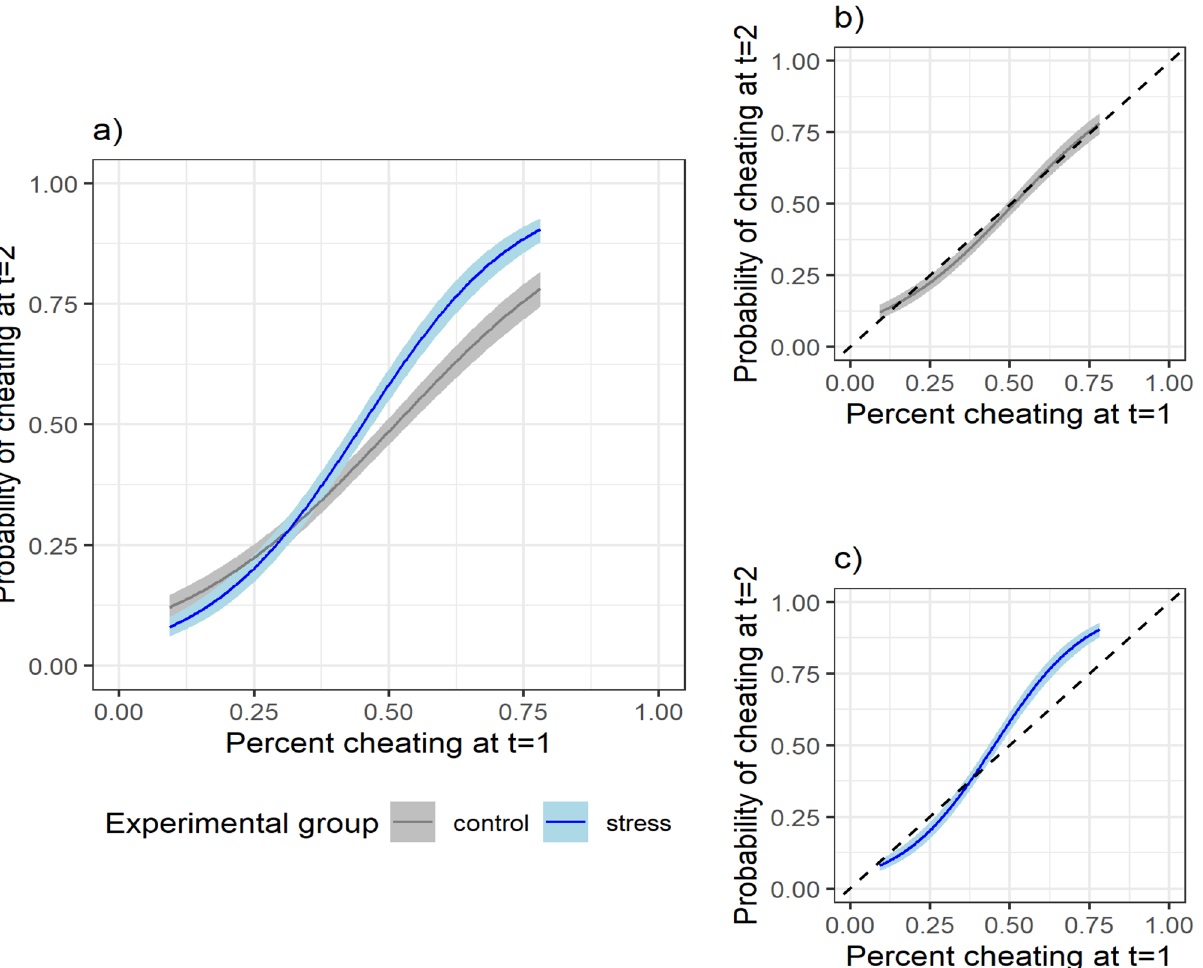
Figure 3. Estimated probability of cheating in the second block of the SPOT (t = 2) as a function of cheating during the first block (t = 1) and experimental group (n = 96 participants, with n = 52 in the control and n = 44 in the stress group), combined (panel a ) and split for control ( b ) and stress group ( c ). The range of the x-axis matches the observed variation in cheating. Confidence bands represent 95% credible intervals